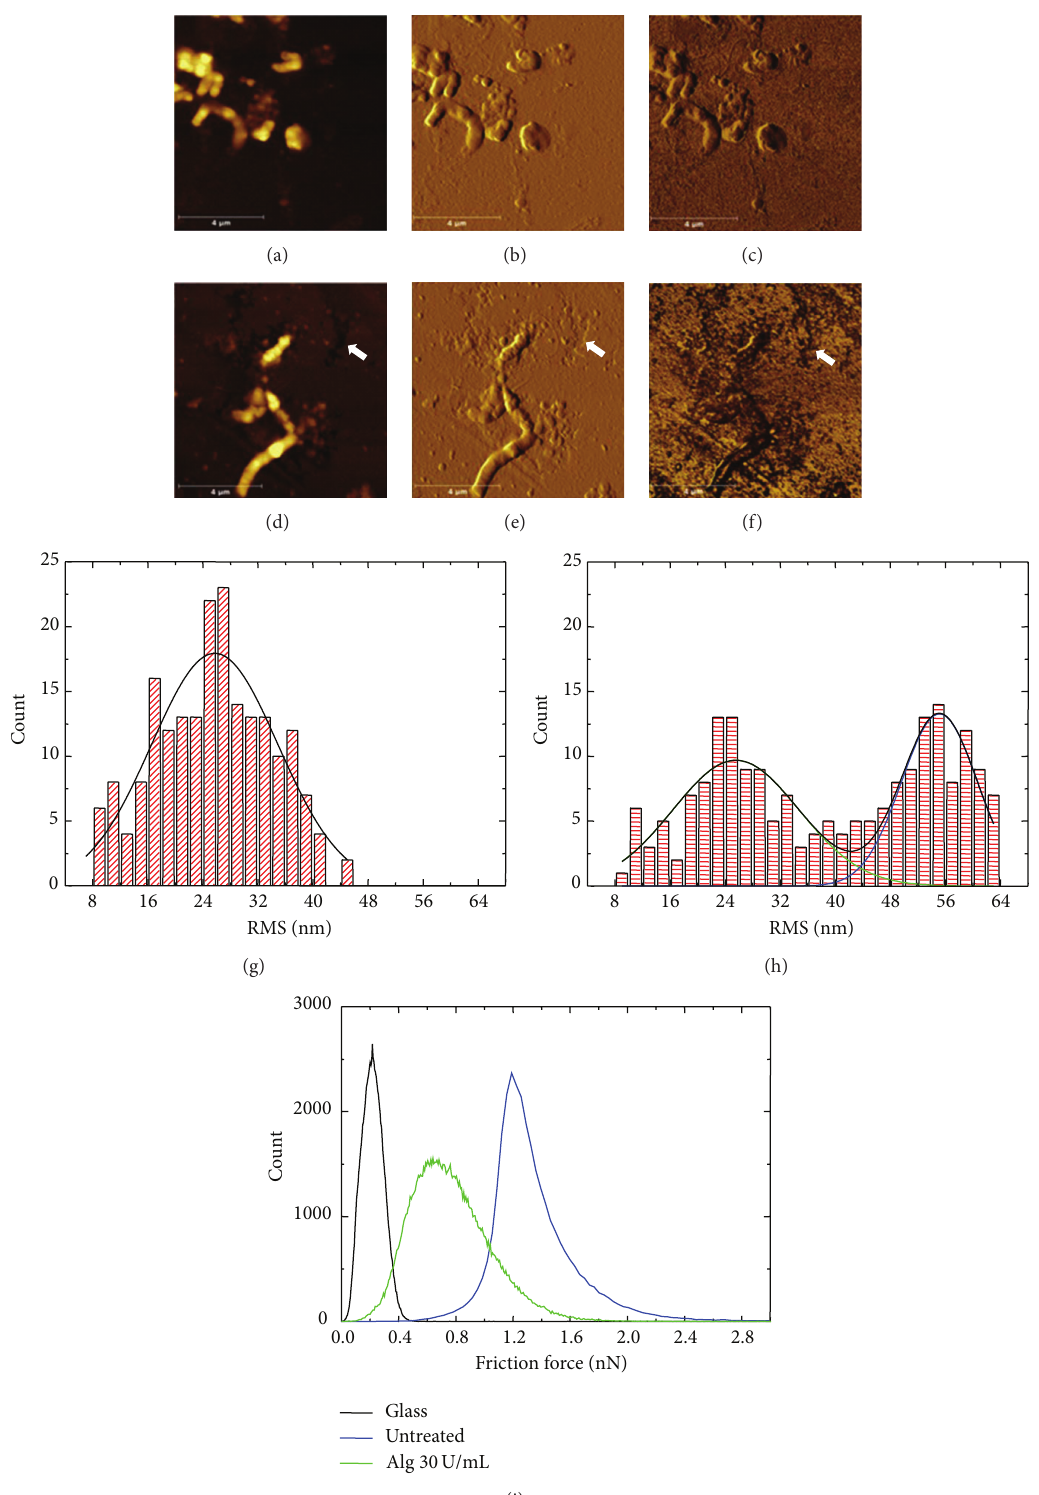
Figure 2: Representative zoom AFM images ( 10 × 10 𝜇 m) of H. pylori biofilm are shown before treatment (a–c) and after treatment with AlgL (e–g). Height images (a and d) show different cells from each experimental condition and the presence of fractures in biofilm generated by AlgL treatment (d). Deflection and lateral images (b, e, c and f) reveal more details in biofilm texture. In Figures (g and h) the roughness distribution and Gaussian fit (black lines) are shown for each sample. The distributions were obtained following the procedure described in Section 2. Distributions of the friction forces between AFM tip and three different surfaces: clean glass, biofilm, and biofilm treated with 30 U/mL AlgL